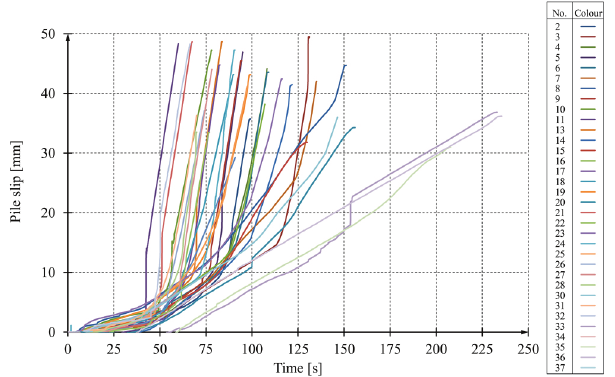
Fig. 13. Pile slip during loading of masonry specimens